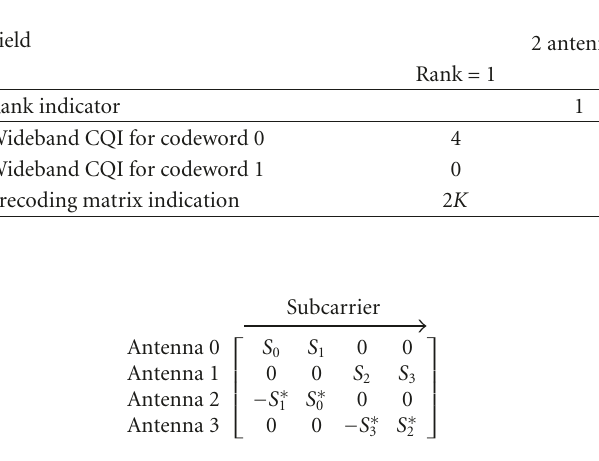
Figure 4: SFBC + FSTD with four transmit antennas on